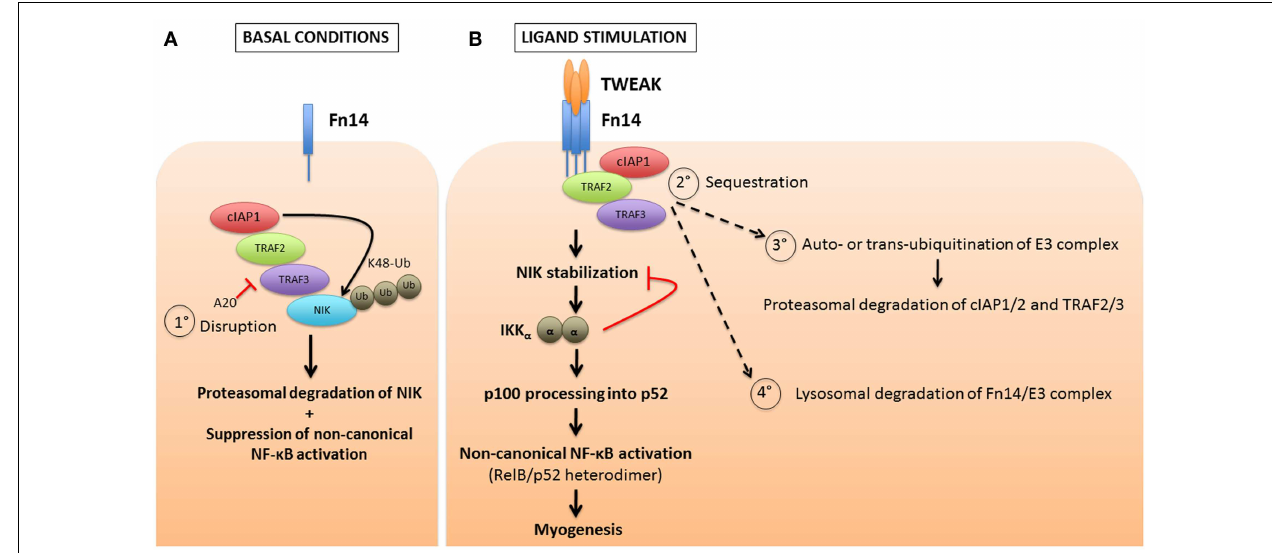
from the cytosolic reactions and sequestered at the plasma membrane (process 2 ° ).This allows for the stabilization of NIK, the formation of IKK α homodimers, and ultimately the partial processing of p100 into p52. RelB and p52 then dimerize to form an active, functional NF- κ B transcription factor complex. Several models of receptor-mediated non-canonical NF- κ B activation have been proposed, which include the cIAPs inducing K48-linked ubiquitination of themselves and theTRAFs, resulting in their proteasomal degradation (process 3 ° ). Alternatively, the receptor-mediated endocytosis of theTWEAK-Fn14 complex results in lysosomal degradation of the cIAPs and TRAFs (process 4 ° ).This loss of cIAP andTRAF adaptors may impact other pathways, such as CD40L signaling through CD40, that also require these